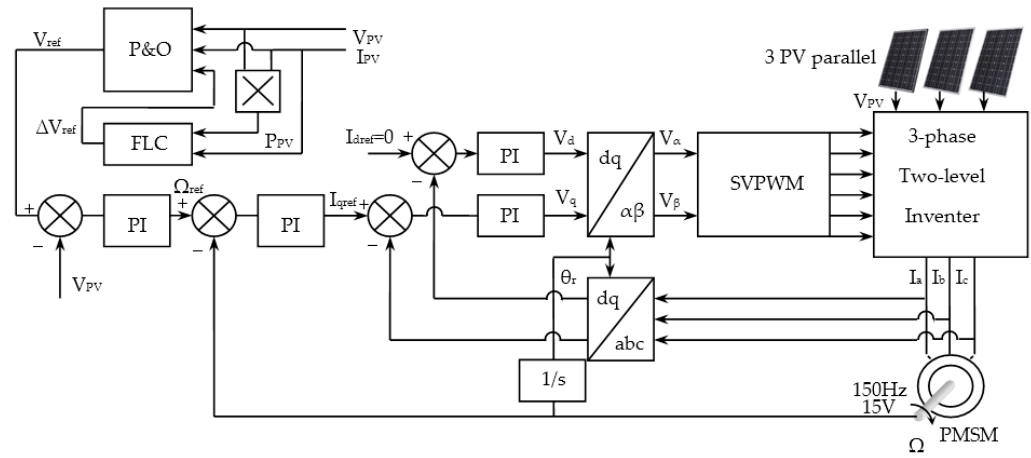
Figure 6. Global schematic of the permanent magnet synchronous motor (PMSM) controlled.